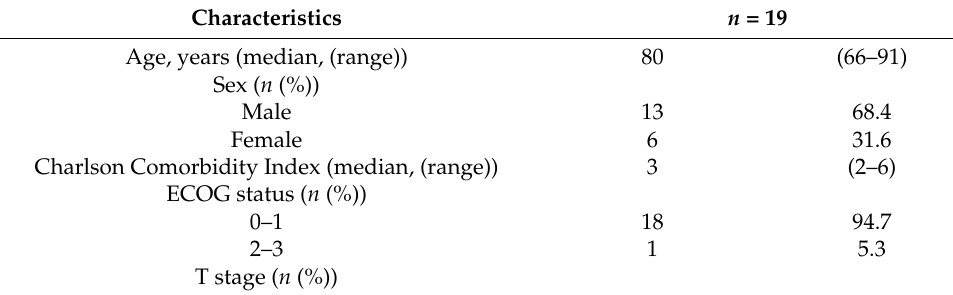
Table 1. Baseline characteristics of the patients and